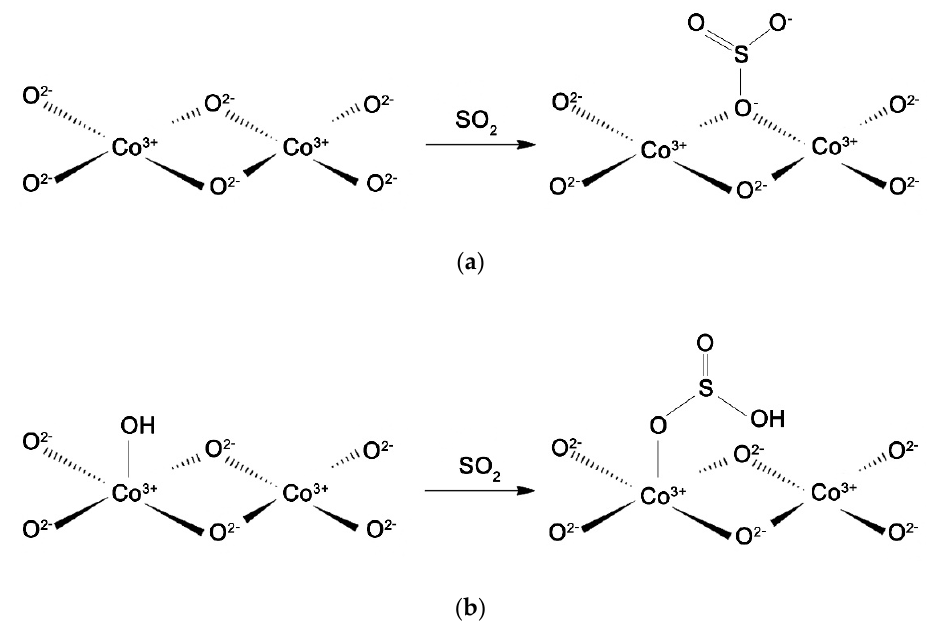
Figure 10. SO 2 adsorption on the Co 3 O 4 surface: ( a ) on O 2 − centers; ( b ) on hydroxyl groups.